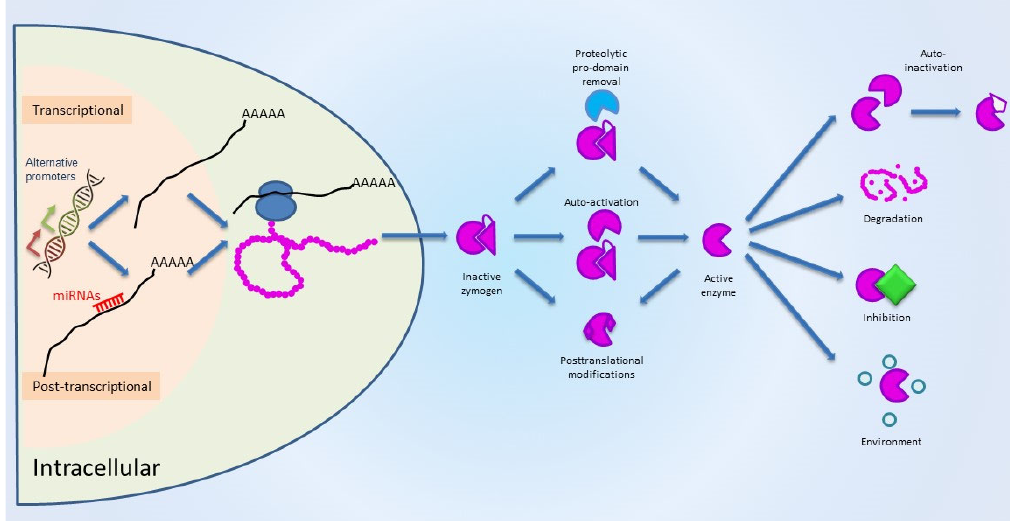
Figure 1. Proteases are controlled at multiple levels. Proteases are regulated at the level of transcrip- tion through alternative promoters, production of splice variants, and DNA/promoter methylation, and post ‐ transcriptionally through miRNAs and alternative polyadenylation signals. Fine tuning of the enzymatic activities of proteases is additionally achieved post ‐ translationally, since they are syn ‐ thesized as zymogens that require activation. In turn, active proteases may be inhibited via binding to specific endogenous inhibitors, while their activities can be altered by changes in the pH, by chemical modifications or cleavage by other proteases or degradation (e.g., by the ubiquitin ‐ pro ‐ teasome system).